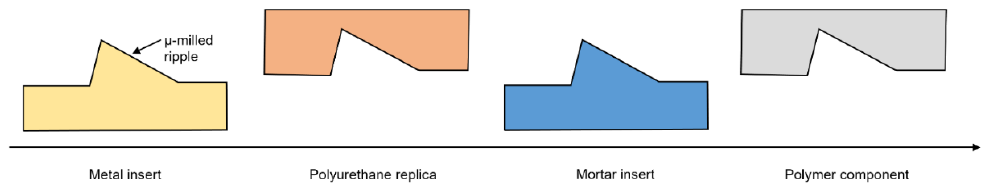
Figure 3. Mirroring of geometry throughout process steps.